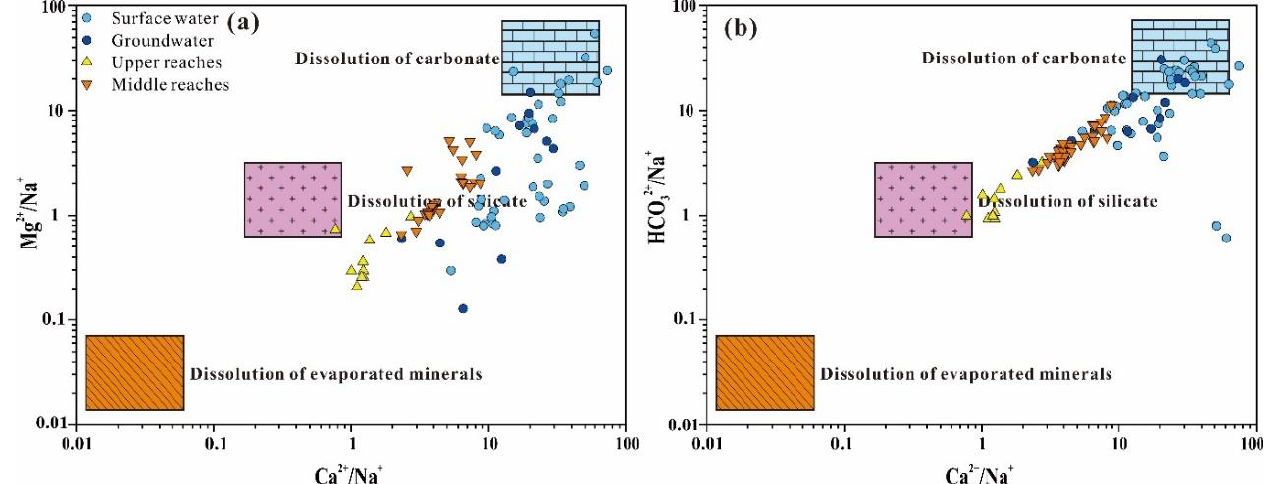
Figure 8. Ratio diagram of Ca 2+ /Na + − Mg 2+ /Na + ( a ) and Ca 2+ /Na + − HCO 3 − /Na + ( b ). Data are from Tables 1 and 2.